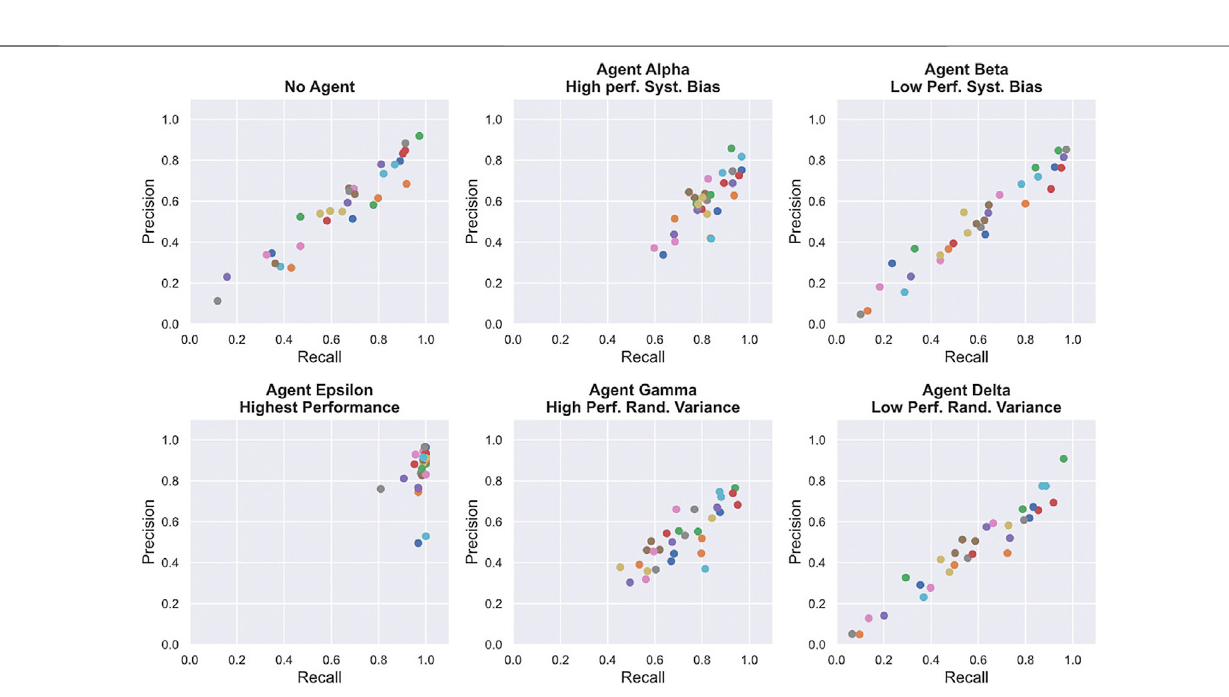
Frontiers in Robotics and AI |